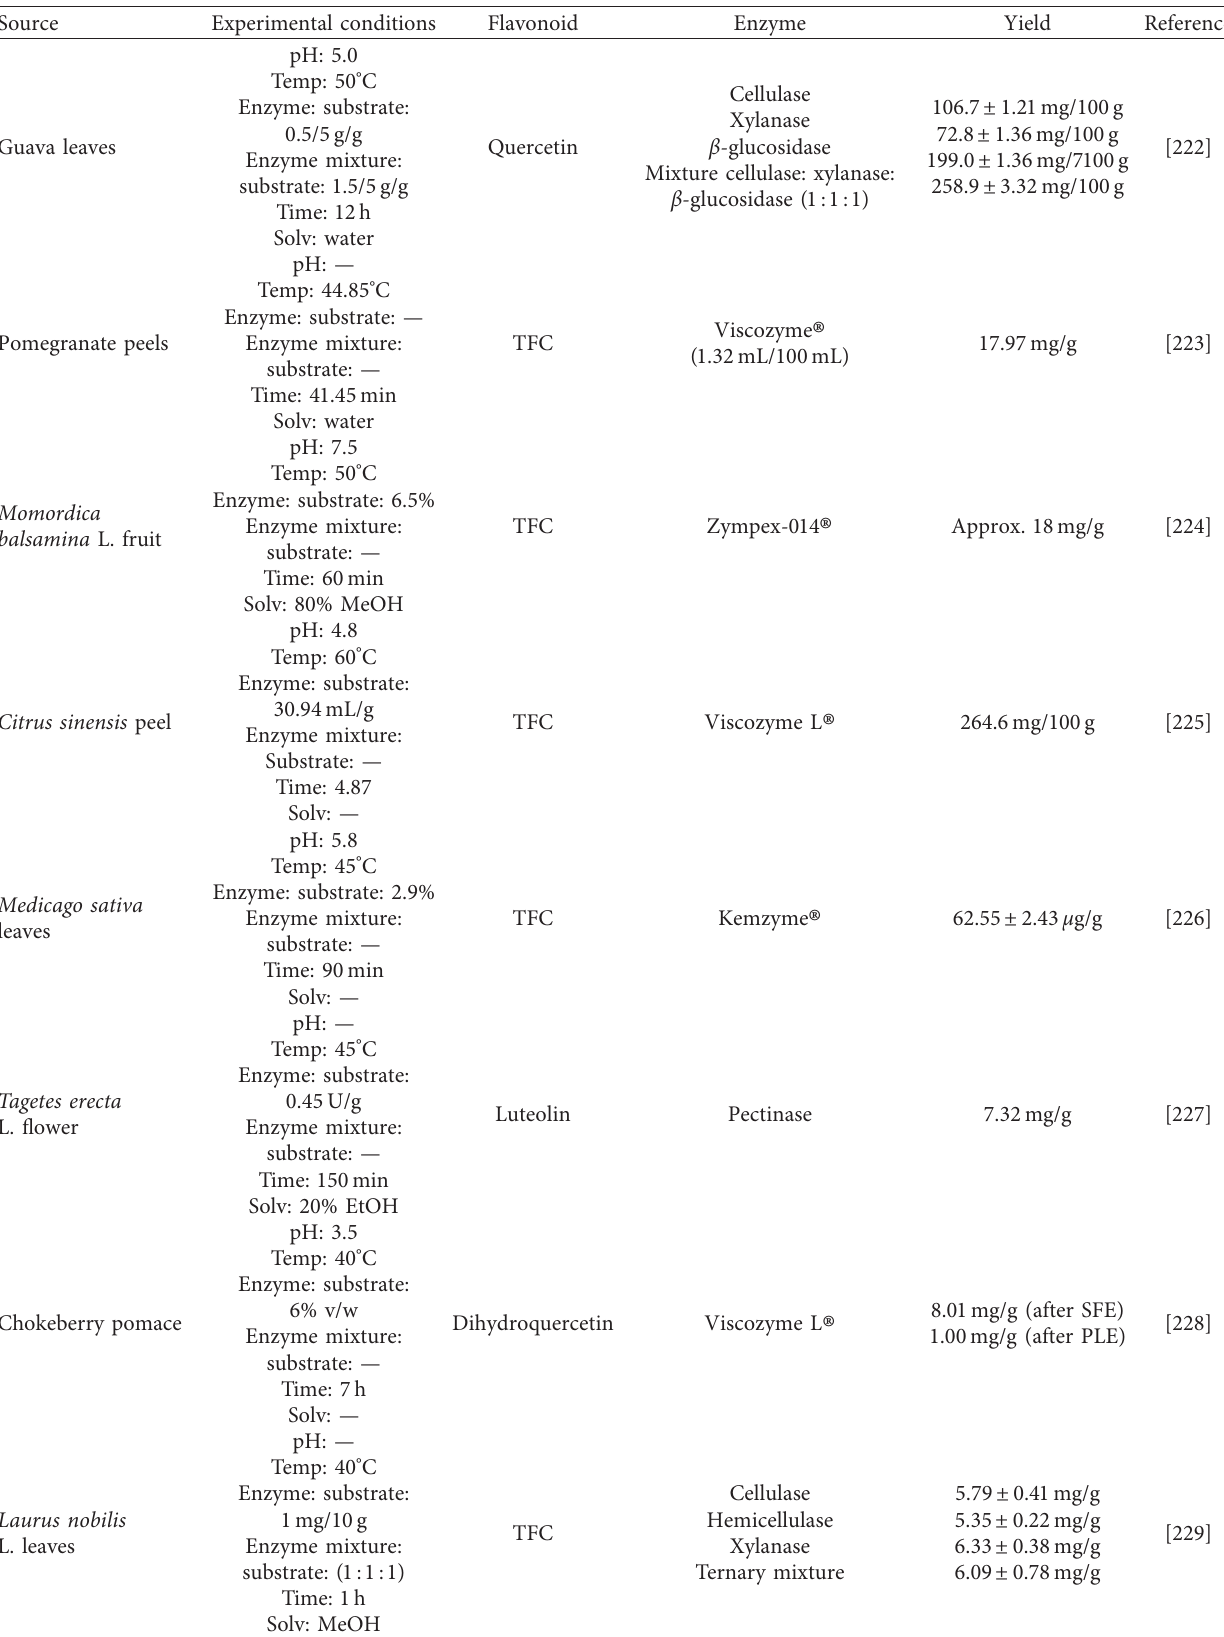
Table 6: Experimental conditions for enzyme-assisted extraction of